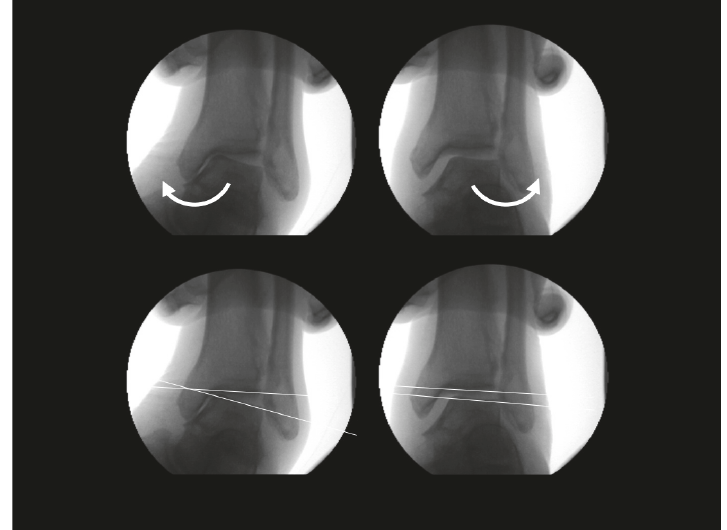
Figure 9: Instability of talotibial